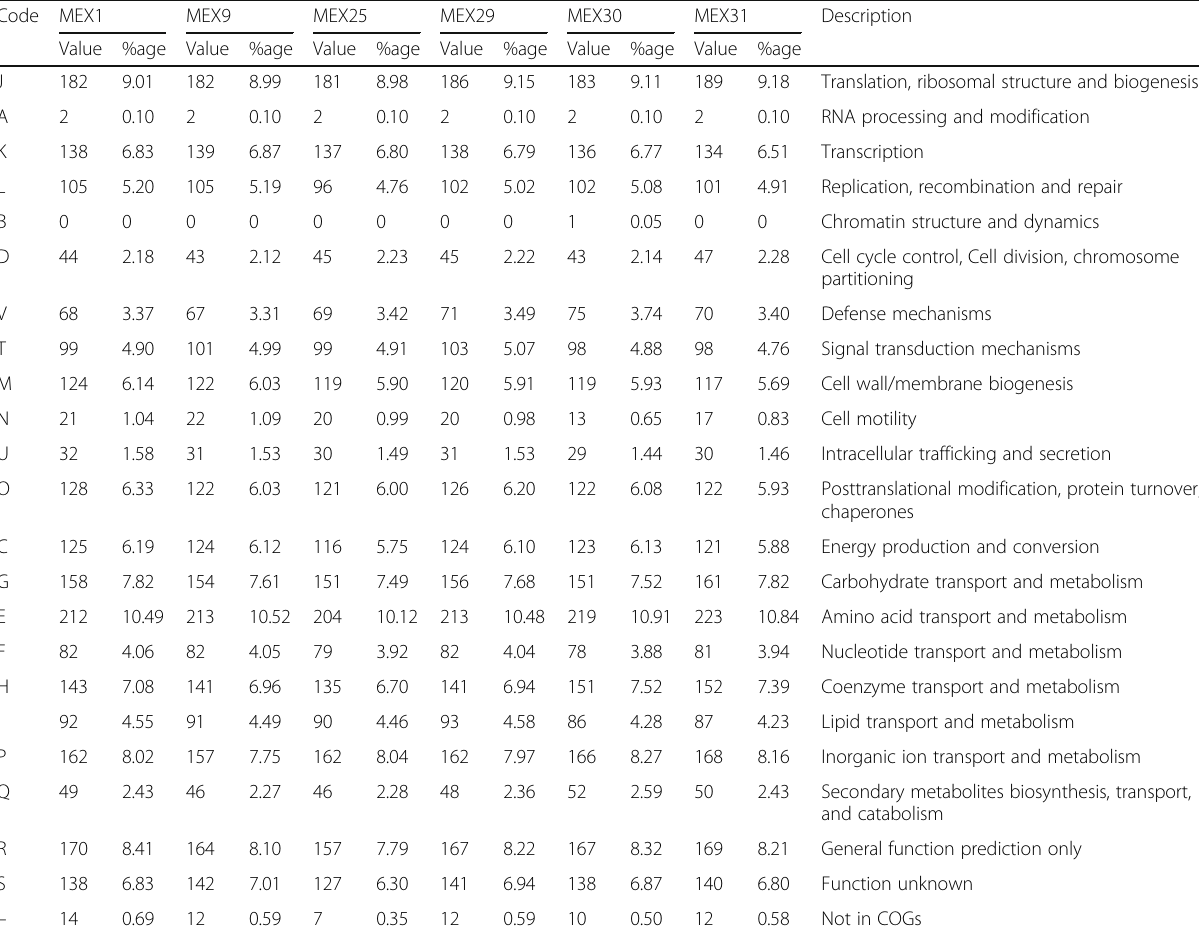
Table 4 Number of genes associated with general COG functional categories Code